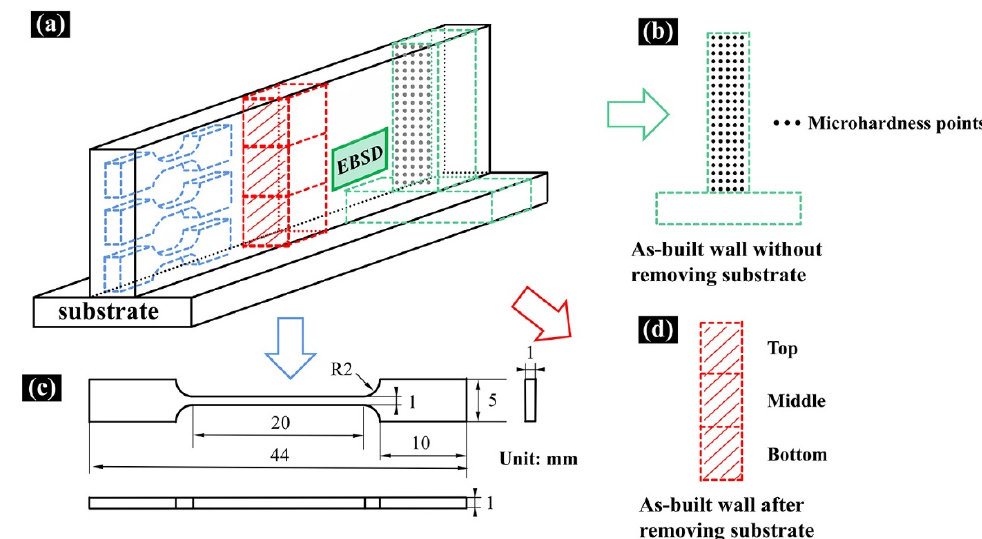
Figure 4. Sampling location and size diagram: ( a ) Sampling location; ( b ) Microhardness sample; ( c ) Tensile sample and size; ( d ) OM and XRD samples.